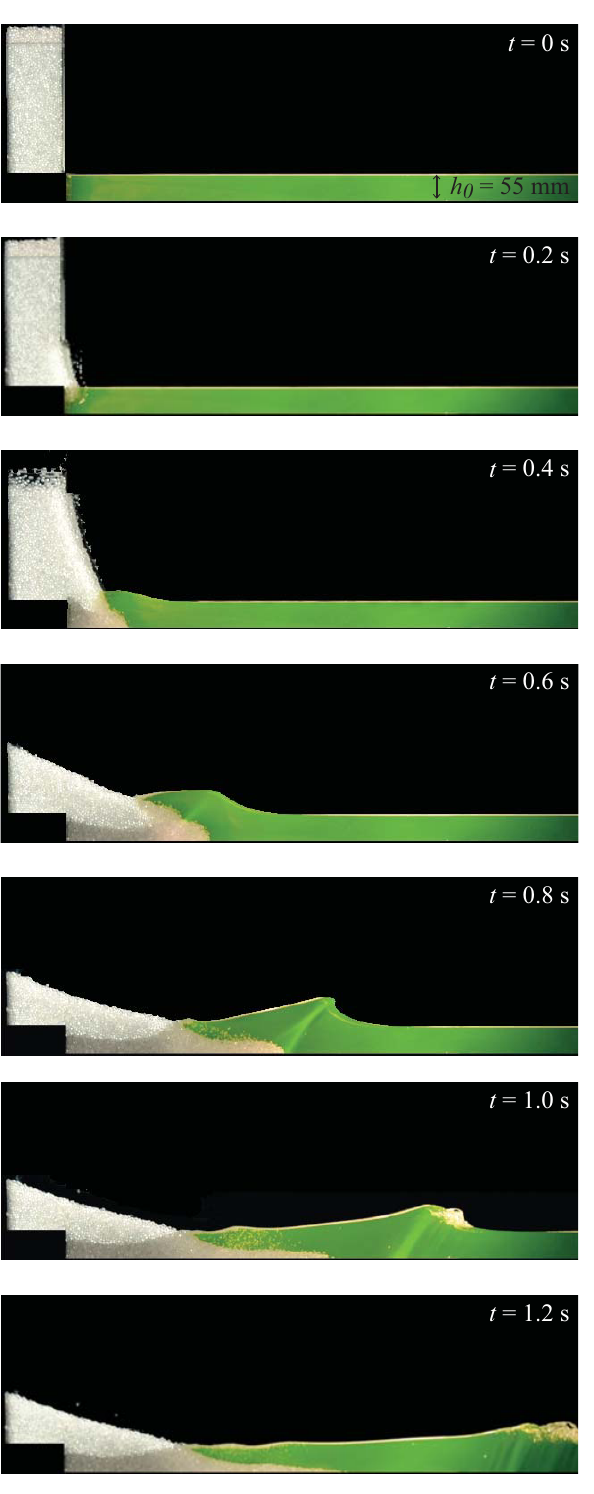
Figure 3. Image sequence showing the propagation of a breaking wave due to the collapse of a granular column (mass M = 6 . 5 kg, aspect ratio a = 2 . 7) of 5 mm glass beads into h 0 = 55 mm of water.